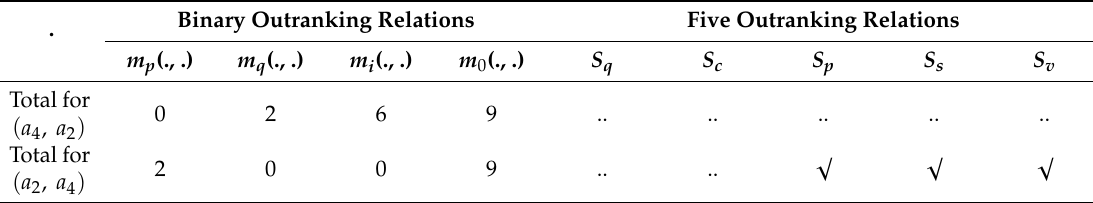
Table 14. Five outranking relations for a comparison of configurations E (5) and C (3). . Binary Outranking Relations Five Outranking Relations m p (.,